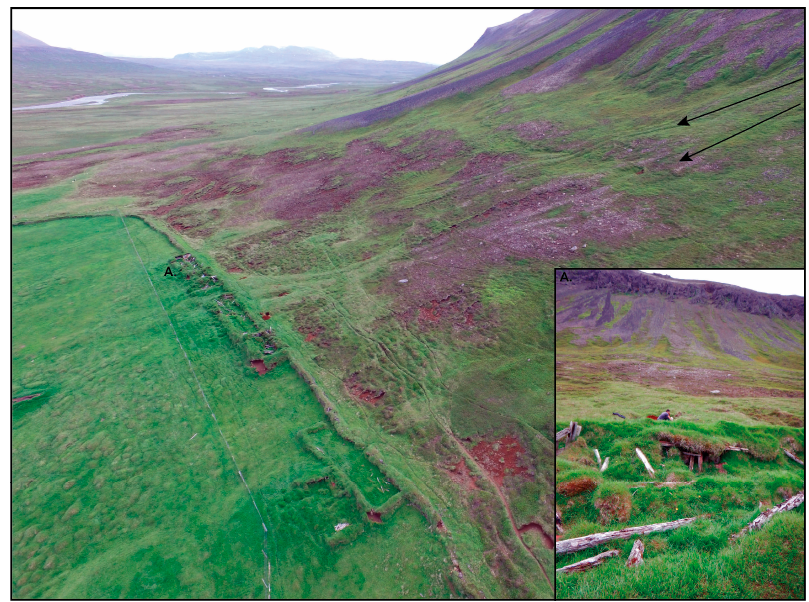
Figure 3. Aerial view from a drone looking towards the south of the western part of the field at the Flautafell farm. ( A ) A view from the ruins looking towards the slope. Farm ruins are visible in the foreground and snow avalanche landforms can be seen in the background.